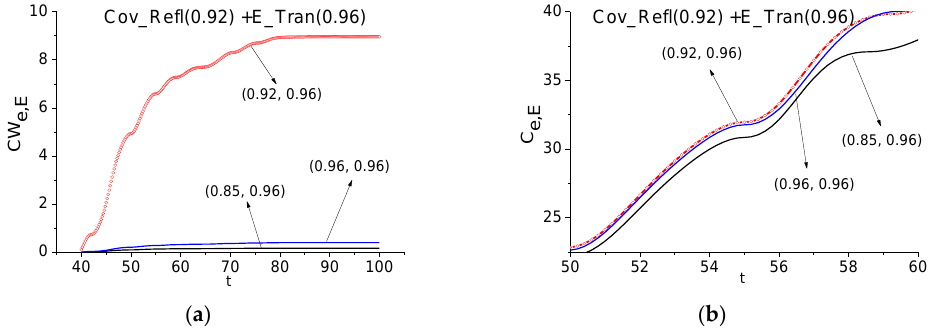
Figure 14. Evolution of the ICC CW e,E ( a ), C e,E ( b ) calculated for the frequency ν = 0.92 using the Cov_Refl signal and the E_Tran signal as a standard one.